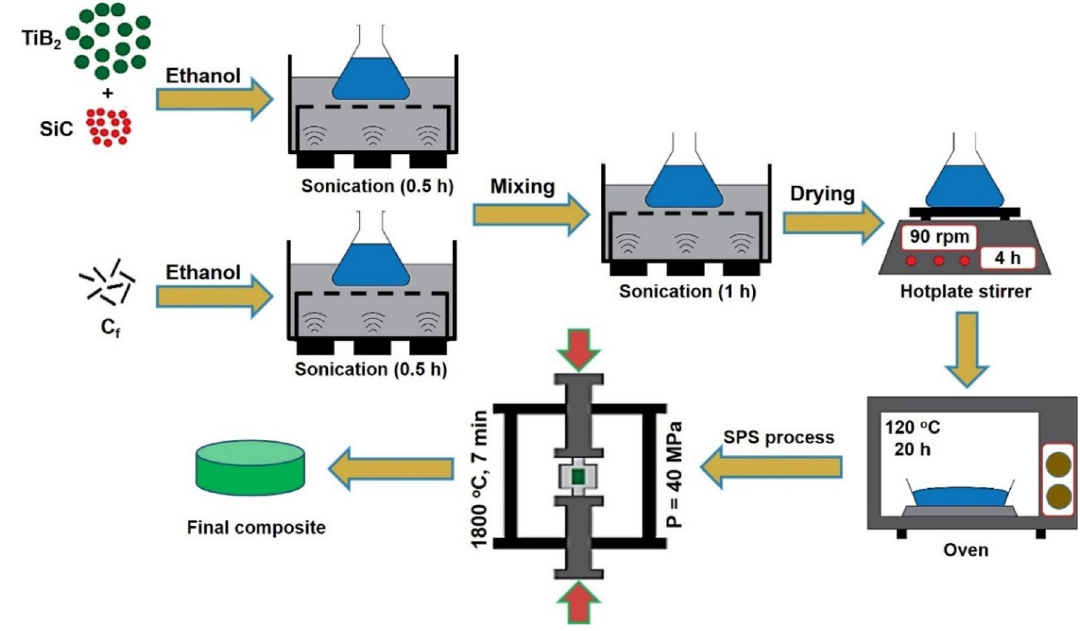
Figure 1. Preparation procedure of C f -incorporated TiB 2 –SiC